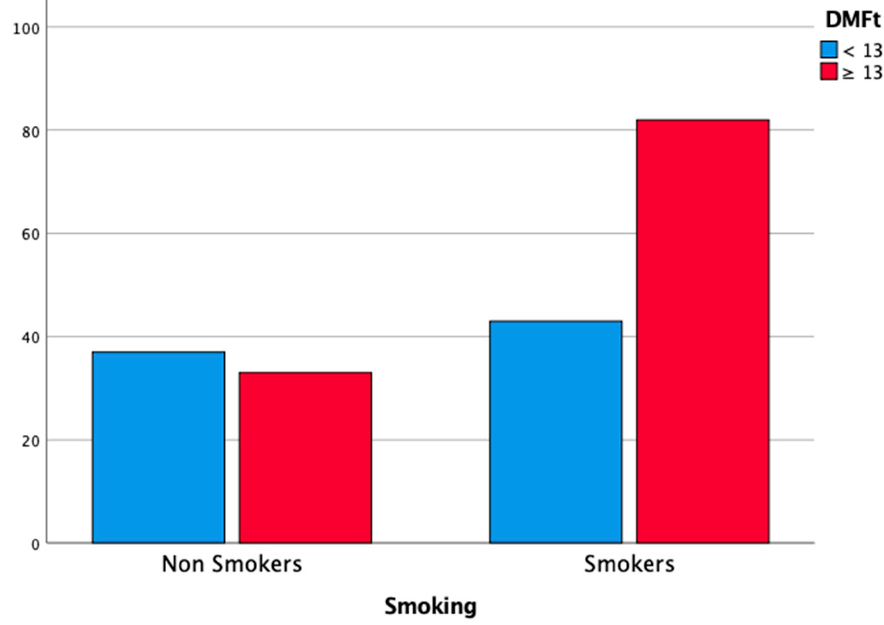
Figure 2. Distribution of DMFt < 13 according to the habit of smoking.